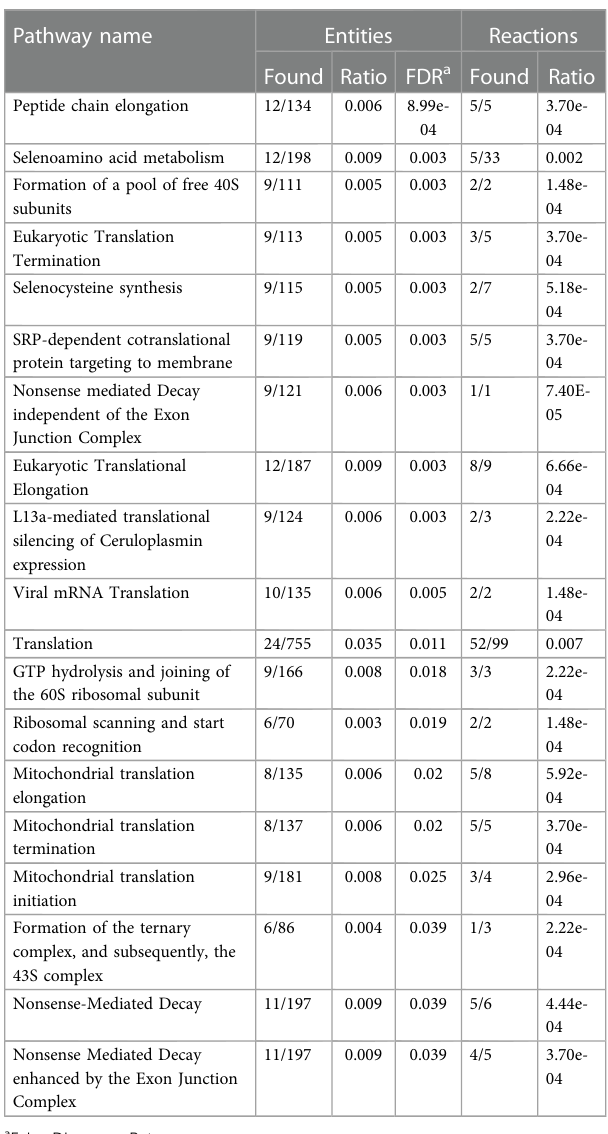
TABLE 2 Reactome pathways sorted by p -value for the top 185 overlapping stability selected ranked genes from GSE147902 and GSE66099 comparing children with a P a O 2 /F i O 2 <200 with a P a O 2 / F i O 2 ≥ 200 –